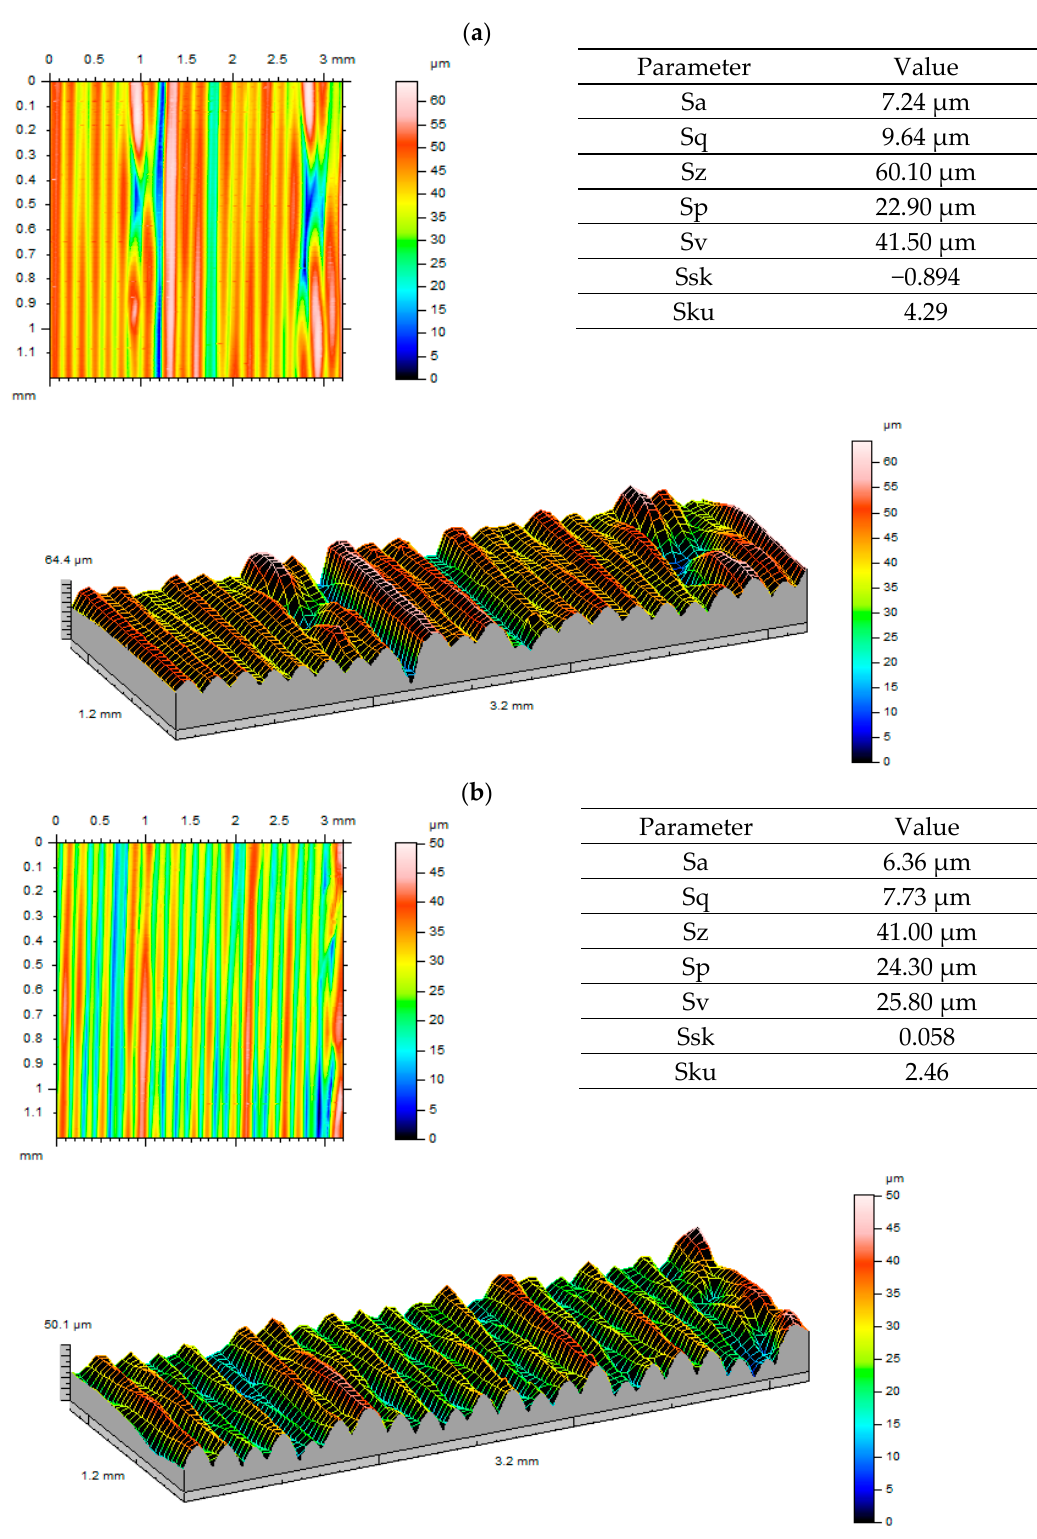
Figure 12. Roughness measurement results for the PEEK material: ( a ) before testing; ( b ) after testing.